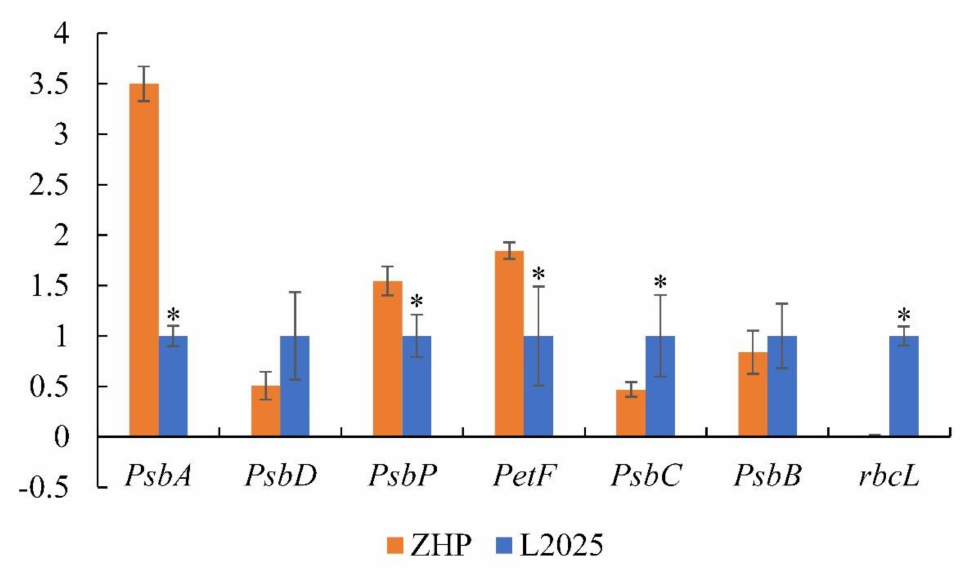
Figure 6. Expression analysis of selected photosynthesis-related genes from leaves between ‘L2025’ and ‘ZHP’ as determined by qPCR. Data are means ± SE ( n = 3). Values of * indicate significant difference according to Student’s t -test ( p <